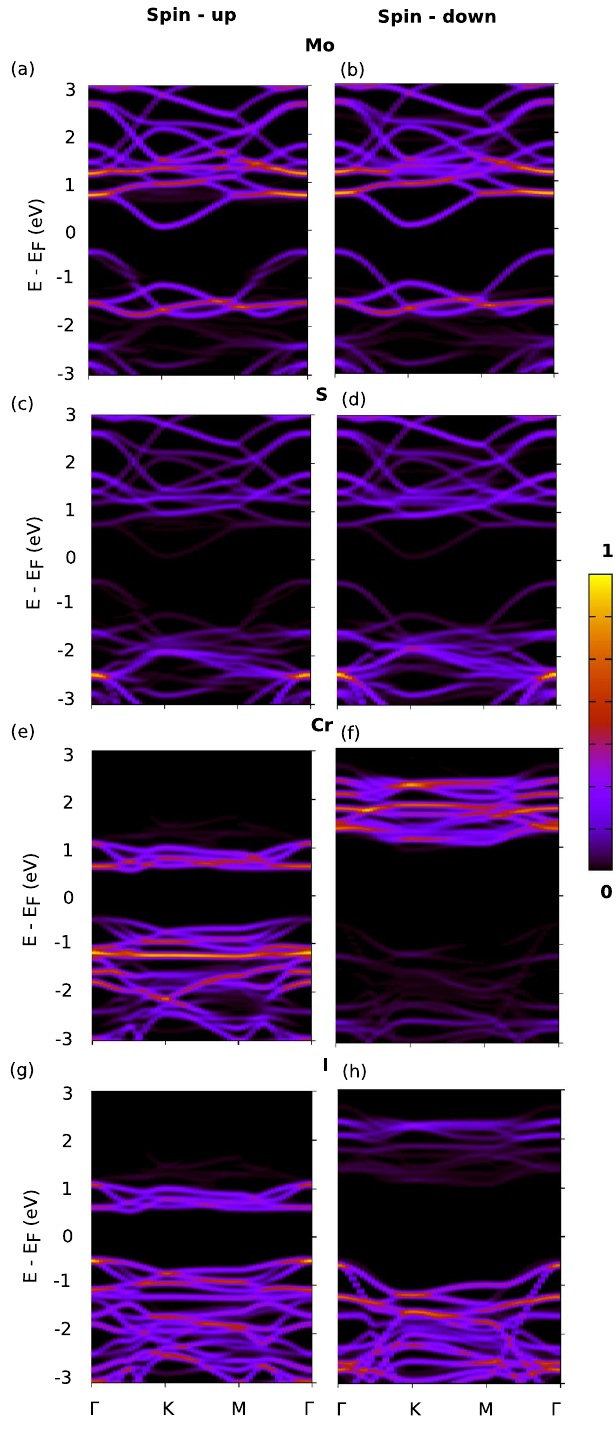
Figure 3. The k-resolved DOS projected on individual atom types (KDOS(k,E)) refer to “Simulation methods” section for details) is shown for ( a , b ) The spin up and spin down bands for 2:1 MS/CrI 3 projected on Mo states respectively. ( c , d ) The spin up and spin down bands projected on S respectively. ( e , f ) The spin up and spin down bands projected on Cr respectively. ( g , h ) The spin up and spin down bands projected on I respectively. The color scale has been normalized with respect to the maximum value of the state localized around their respective atom